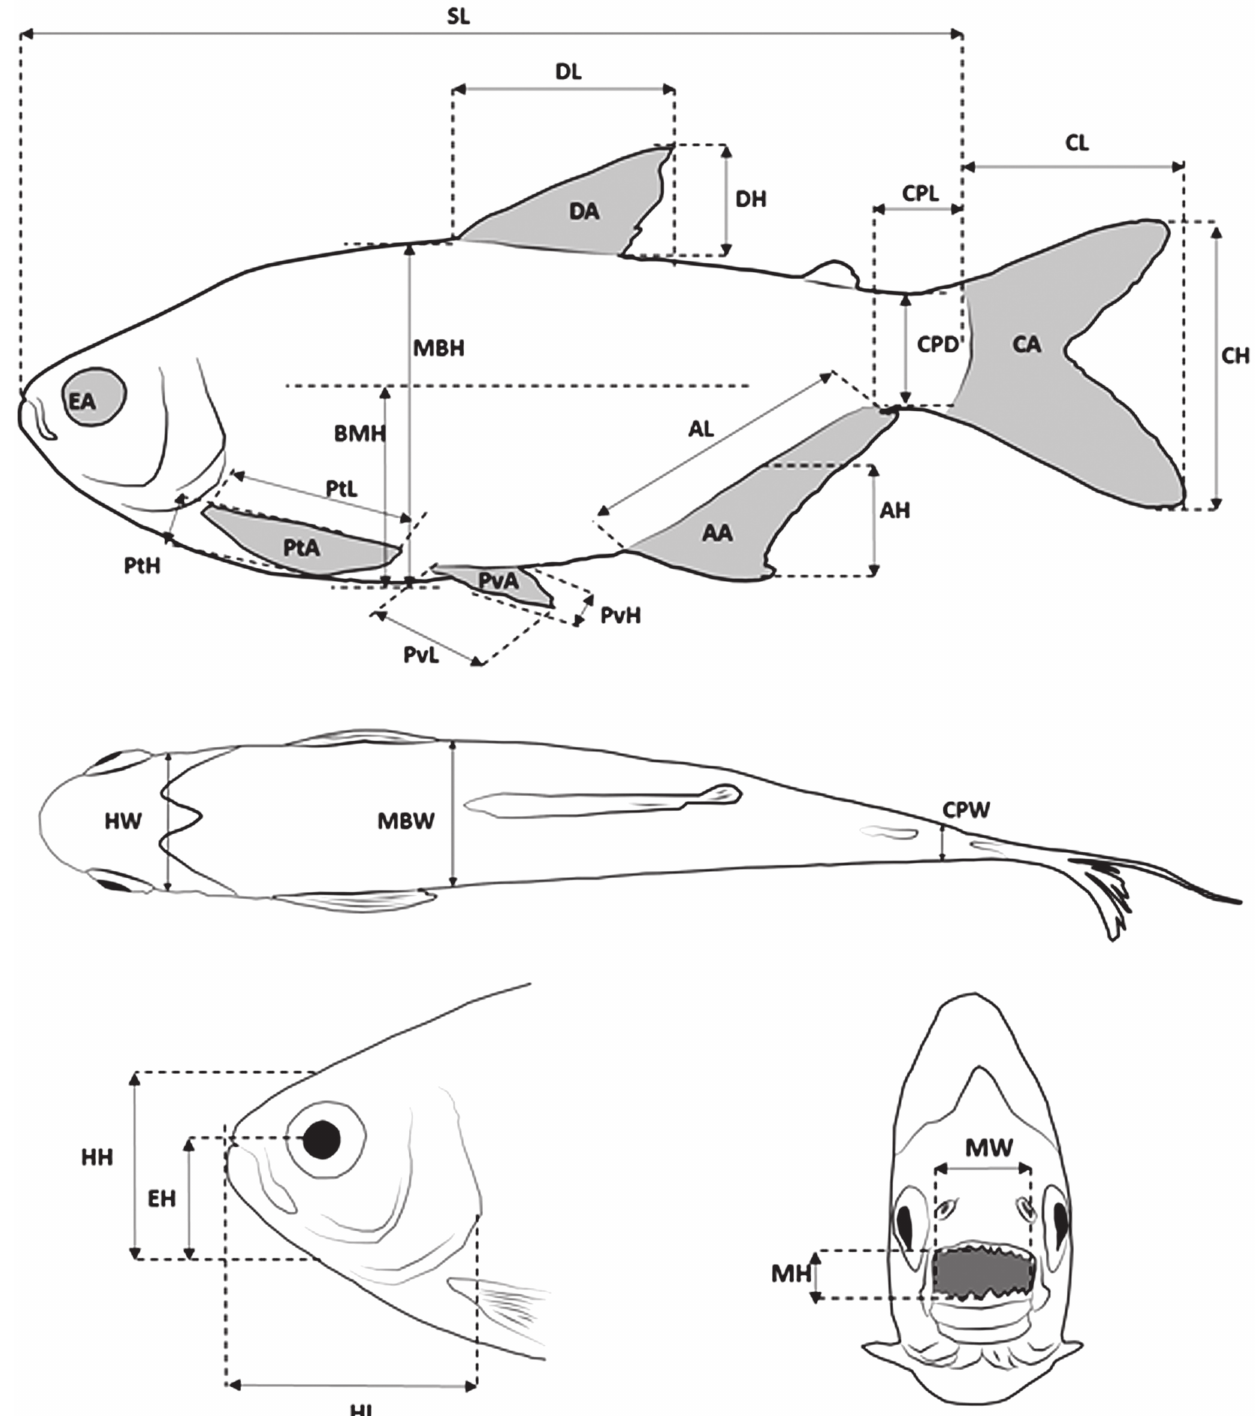
Fig. 2. Representation of the linear morphometric measurements and the calculated areas: standard length (SL), maximum body height (MBH), body midline height (BMH), caudal-peduncle length (CPL), caudal-peduncle depth (CPD), dorsal-fin length (DL), dorsal-fin height (DH), pectoral-fin length (PtL), pectoral-fin height (PtH), pelvic-fin length (PvL), pelvic-fin height (PvH), anal-fin length (AL), anal-fin height (AH), caudal-fin length (CL), caudal-fin height (CH), head width (HW), maximum body width (MBW), caudal peduncle width (CPW), head length (HL), head height (HH), eye height (EH), mouth height (MH), mouth width (MW), eye area (EA), pectoral-fin area (PtA), pelvic-fin area (PvA), dorsal-fin area (DA), caudal-fin area (CA), and anal-fin area (AA). Schematic representation based on Astyanax fasciatus , CZUT-IC